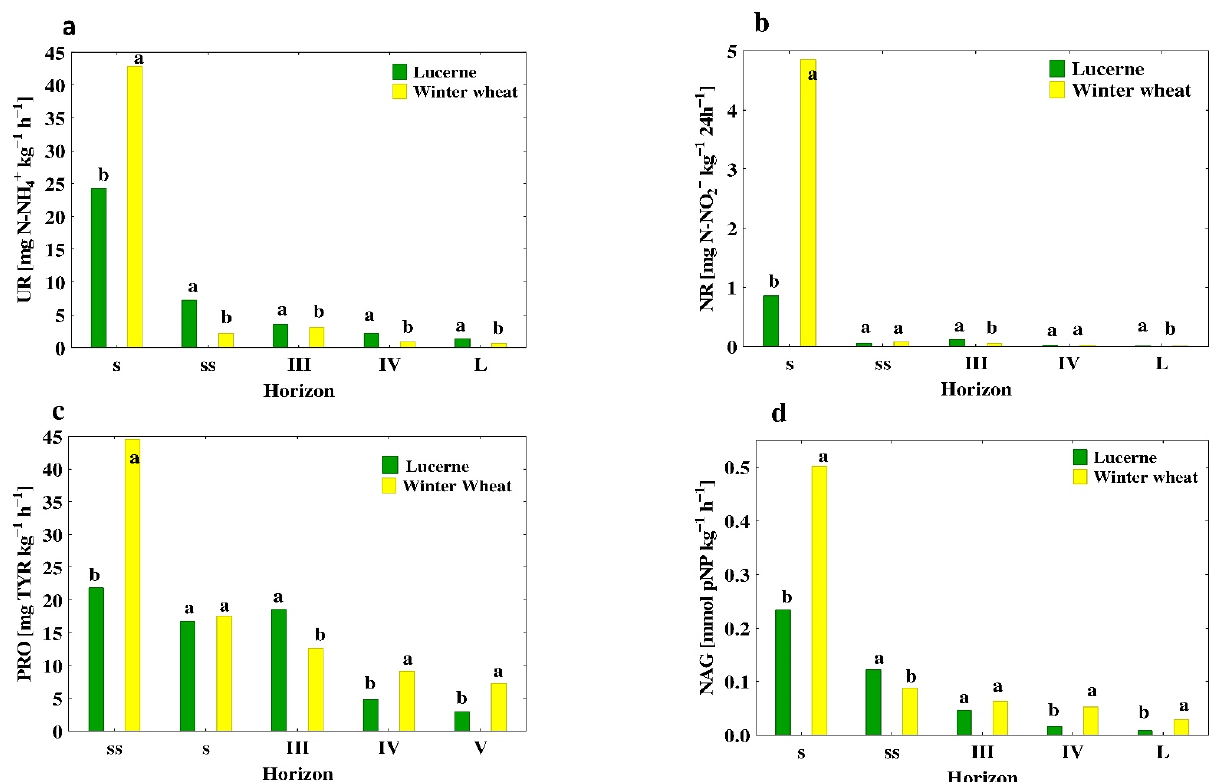
Figure 3. Effect of the cultivated plants on the potential UR ( a ), NR ( b ), PRO ( c ), NAG activity ( d ); s the surface (Ap) horizons, ss the sub-surface horizons, III the middle (thirds) horizons, IV the second from the bottom horizons, L the deepest horizons. Values in compared horizons followed by different small letters are statistically different at p < 0.05.